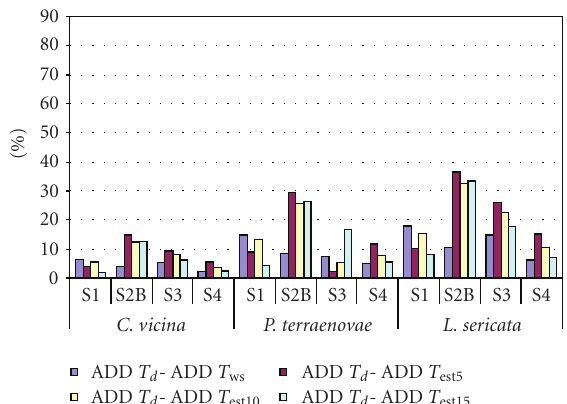
Figure 5: Di ff erences between ADD T d and ADD values using T ws and correlations compared to ADD T d , expressed as percentages ([ADDx-ADD T d )/ADD T d ] × 100) for data registered in